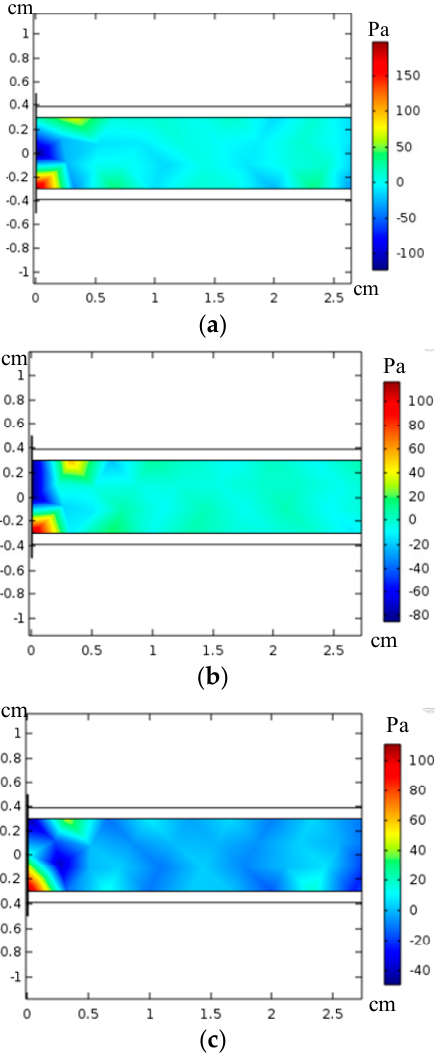
Figure 10. Pressure distribution in porous areas (peak value of 6.28 kA, 200 μ s): ( a ) PVC; ( b ) PET; ( c ) balsa wood.